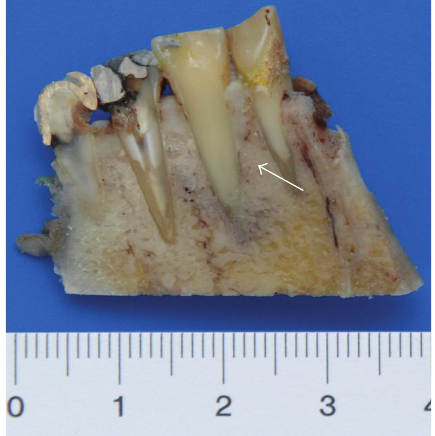
Figure 13: Case 4—the split resection specimen from a lingual view demonstrates the association of tumor formation along the root of the left lower canine (white arrows) as also further invasion of the cancellous bone.